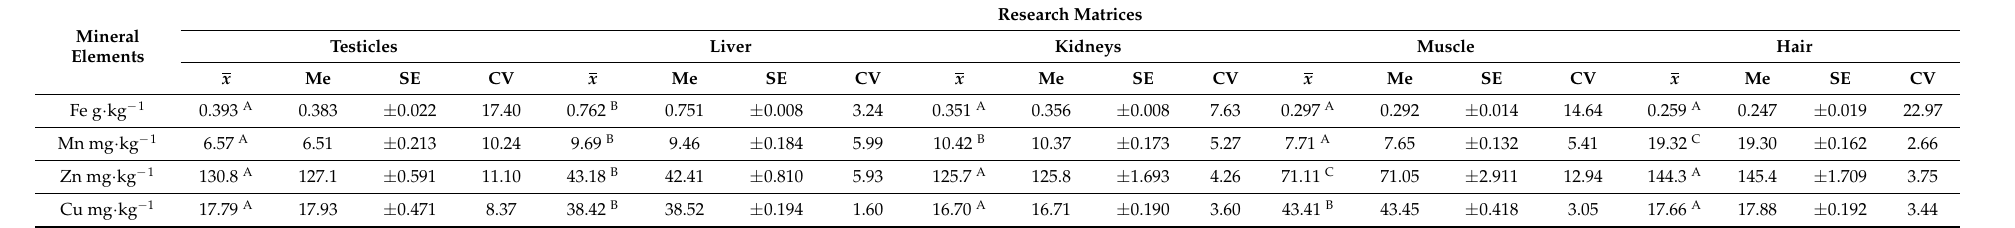
Table 1. The variability factor and content of Mn, Zn, Cu (mg · kg − 1 of d.w.) and Fe (g · kg − 1 of d.w.) in tissues and organs of red deer.